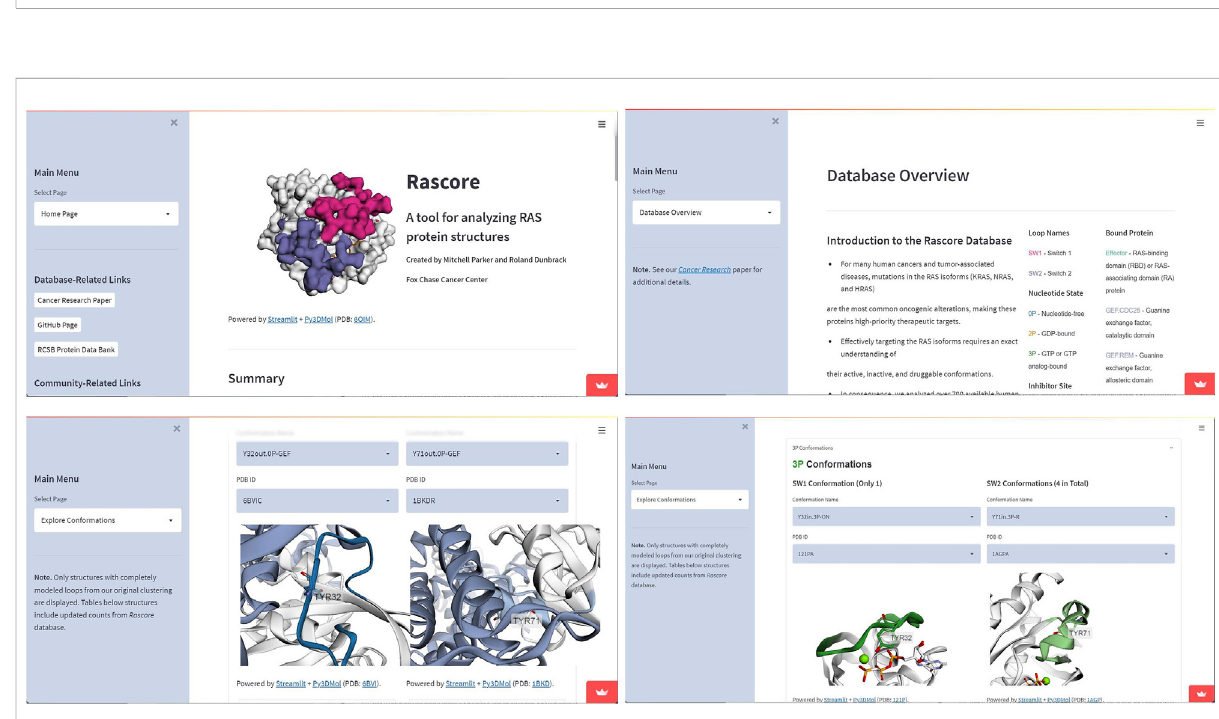
FIGURE 7 Screen-captures showing use case of the Stmol package for the development of the Rascore Web-app. Among its options are “ Main Menu ” , “ Database Overview ” and “ Explore Conformation ” sections where Stmol is used to visualize the structures.